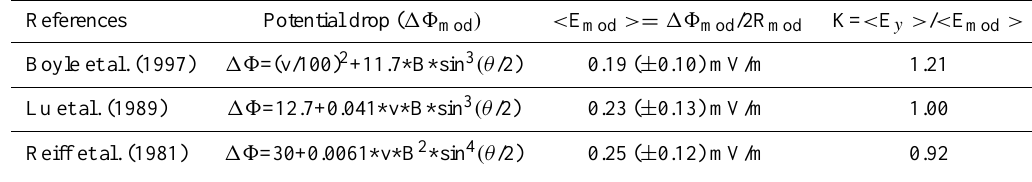
Table 1. Comparison of the modeled and measured plasma sheet electric field values for SMC